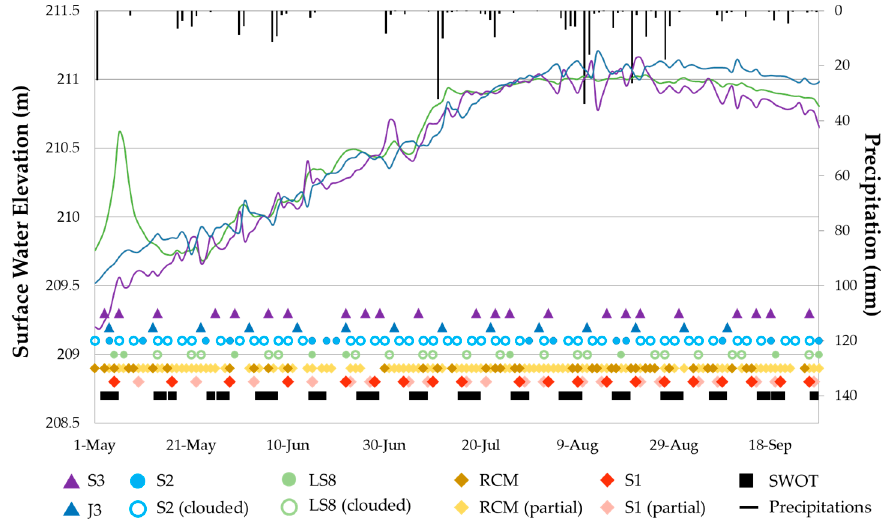
Figure 3. Remotely sensed data acquisition along the 2020 lake expansion event. Lake levels are from Figure 2. Colored lines shows water levels of Mamawi Lake (green), Lake Athabasca (purple) and Lake Claire (blue).